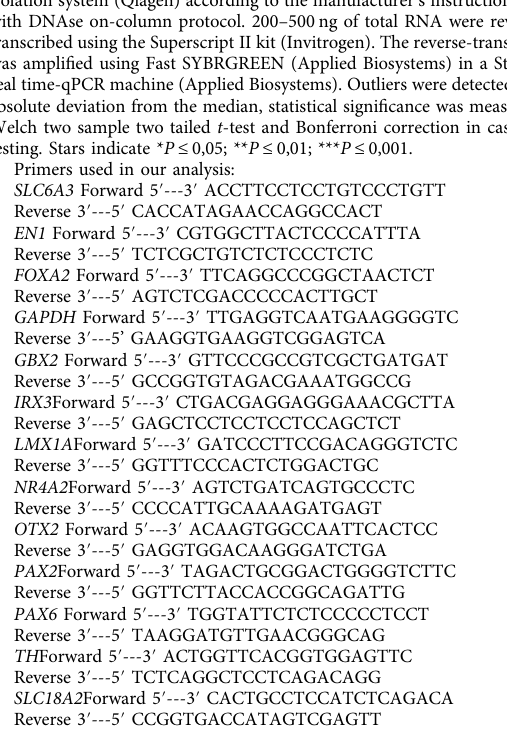
focal microscope (CLICK facility, Karolinska Institute) using the same settings. Cell counts were performed in a blinded fashion in 3 independent experiments, and 6-9 randomly selected fi elds/condition. Control and experimental images were pro- cessed linearly, in the same way, using Fiji software (ImageJ version 1.51t) and Photoshop CS5 (Adobe System